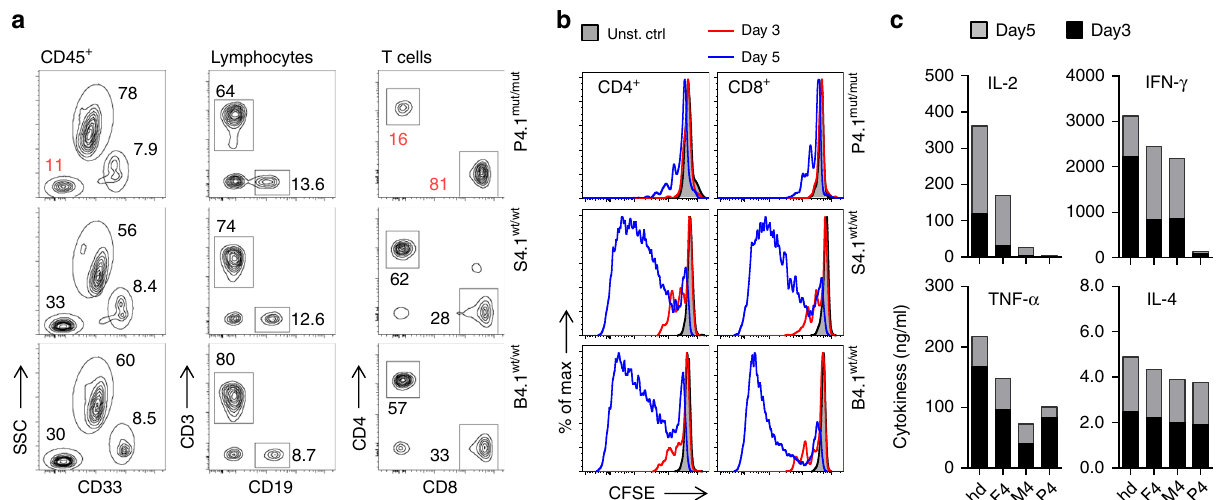
Fig. 6 Patient-associated mutation in FCHO1 gene alters development and activation of T lymphocytes. a Density plots of blood leucocytes (CD45 + ) of the index case (upper row) homozygous for a mutation in the FCHO1 locus and her siblings carrying the heterozygous mutation (middle and bottom rows). T helper cells were de fi ned as CD45 hi CD33 − SSC lo CD3 + CD4 + and cytotoxic T cells were CD45 hi CD33 − SSC lo CD3 + CD8 + . Numbers adjacent to the gates indicate percentages. b Histograms of CFSE-labelled T lymphocytes stimulated with anti-CD3 and anti-CD28 Ab for 3 (red line) or 5 (blue line) days. Unstimulated controls are depicted in grey. c Cytokine production by lymphocytes of patient and family members after anti-CD3 and anti-CD28 stimulation for the indicated periods of time. IL-2, IFN- γ , TNF- α and IL-4 were determined using cytometric bead assays. a – c Data are representative of